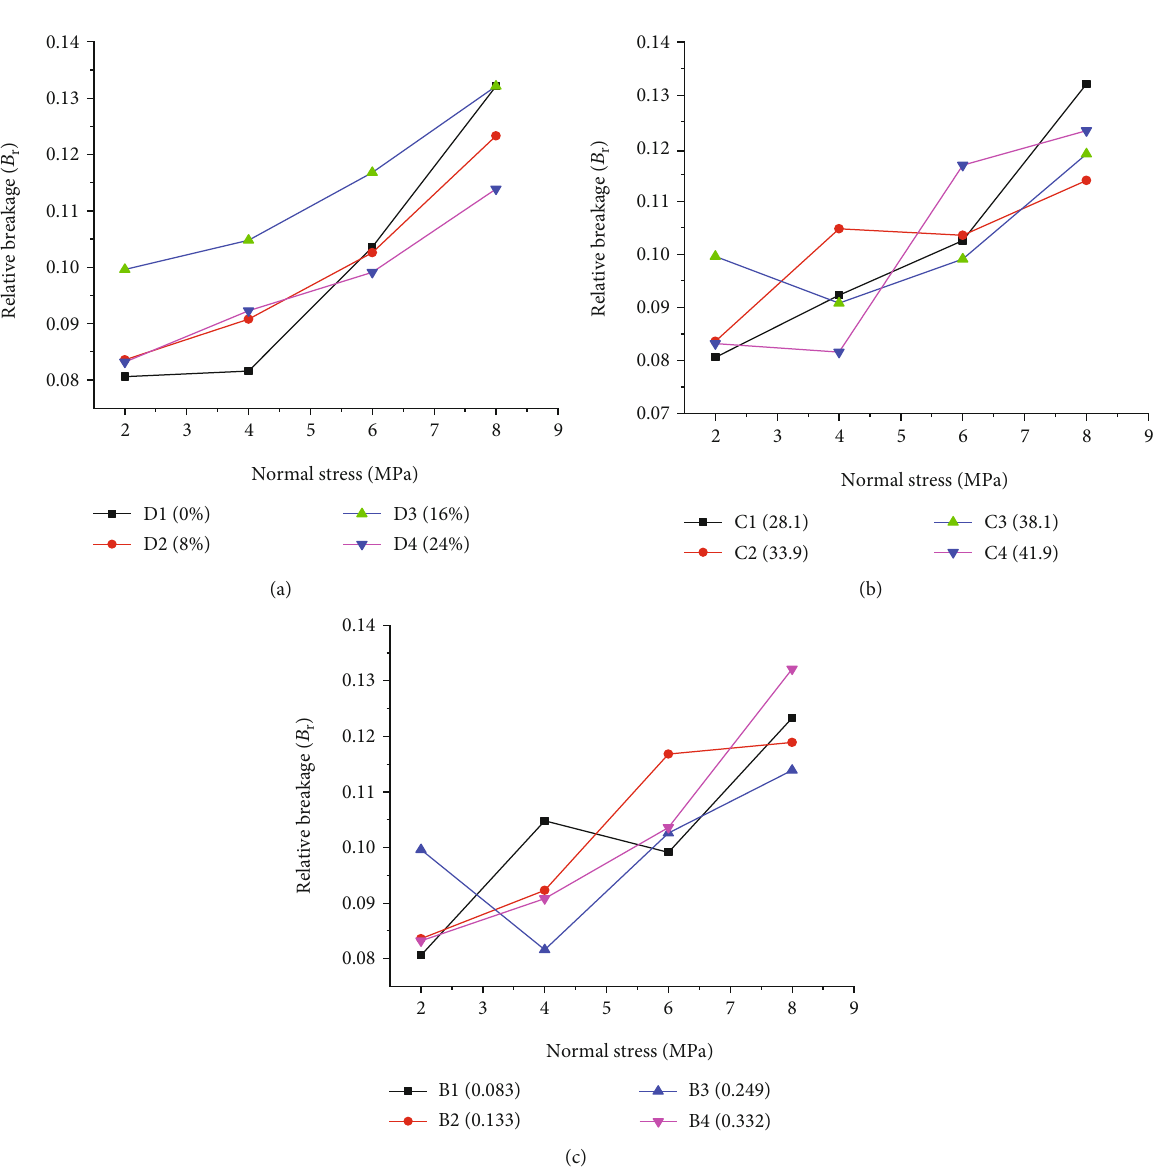
Figure 7: Relationship between relative crushing and normal